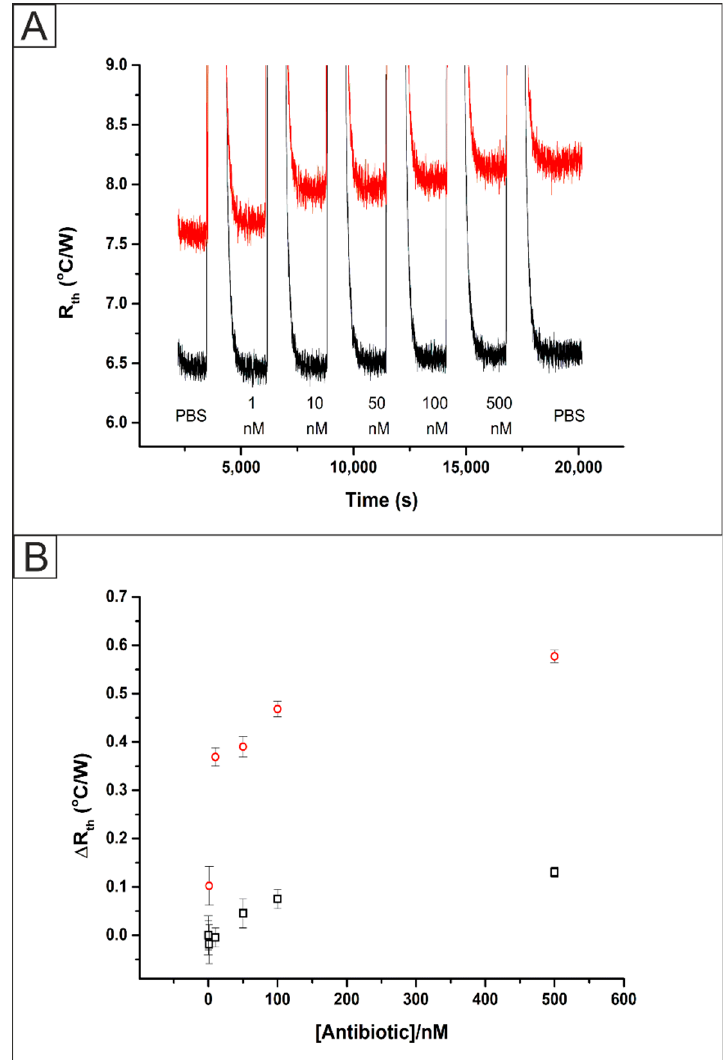
Figure 6. ( A ) The raw HTM data plot of R th versus time for the addition of amoxicillin (1–500 nM, red) and nafcillin (1–500 nM, black) in PBS to an SPE functionalised with a direct UV polymerized MIP. ( B ) Comparison between the absolute R th values obtained from the HTM for a MIP functionalised SPE with additions of amoxicillin (red) and nafcillin (black).